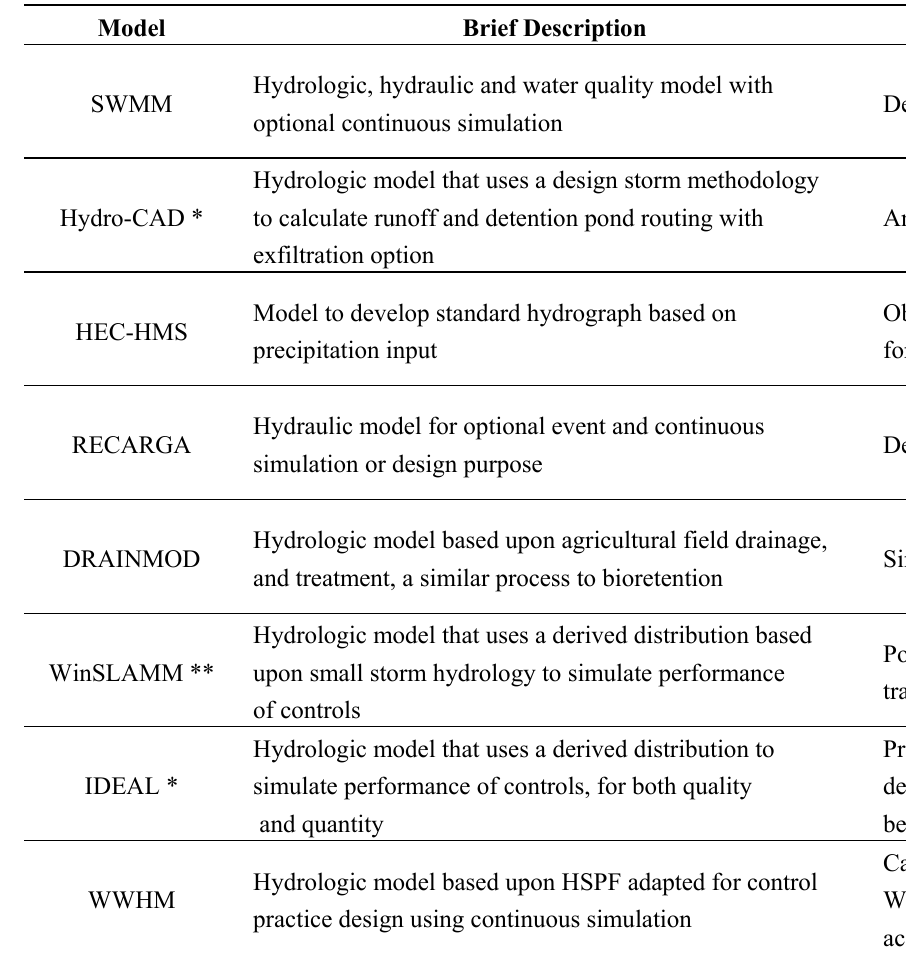
Table 3. Descriptions and uses of major computational models to simulate bioretention